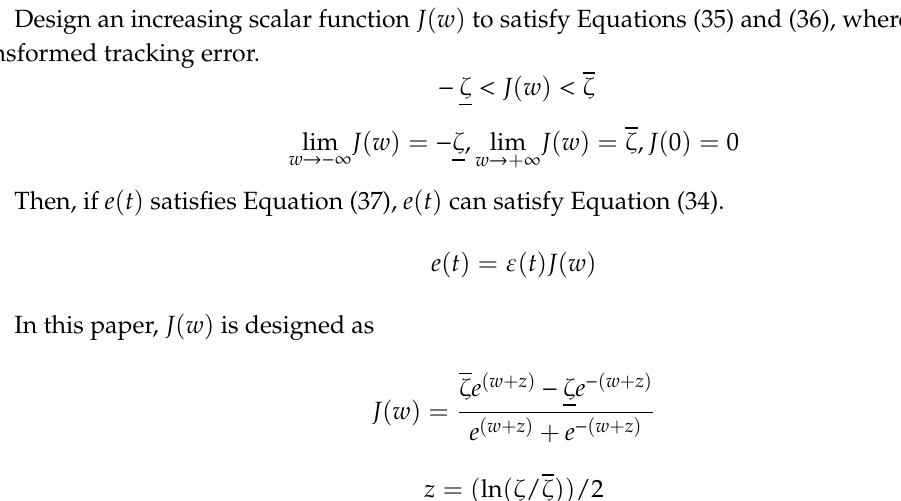
Figure 2. Prescribed performance bound of the tracking error.